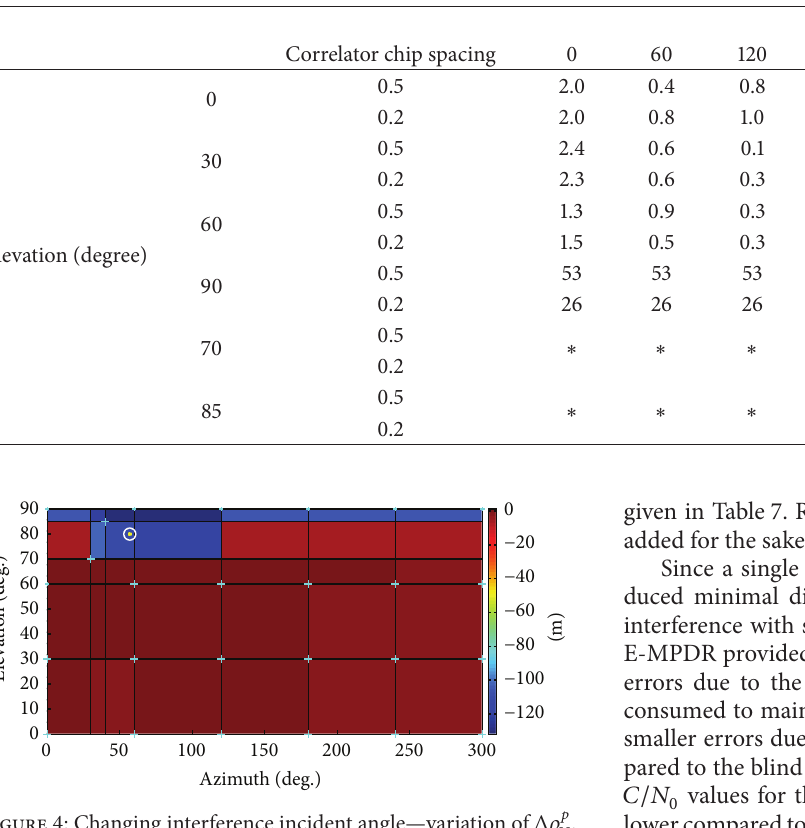
Table 6: Changing interference incident angle: distortion metric (in meters).